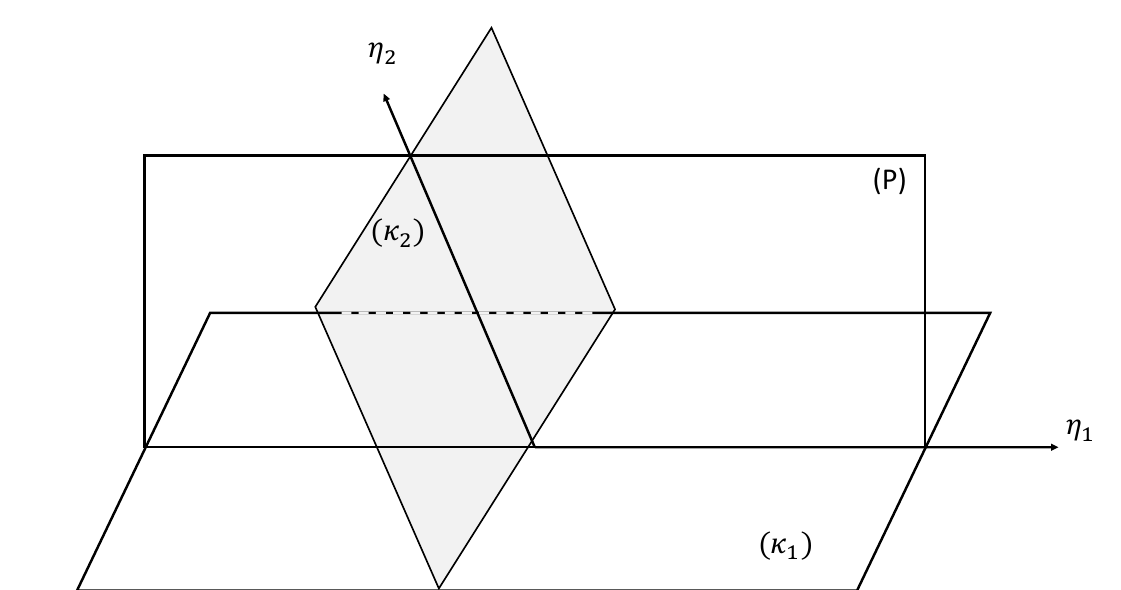
Figure 1. Twinning and conjugate twinning planes K 1 and K 2 along with twinning and conjugate twinning direction, η 1 and η 2 contained in a plane of shear, P , data from